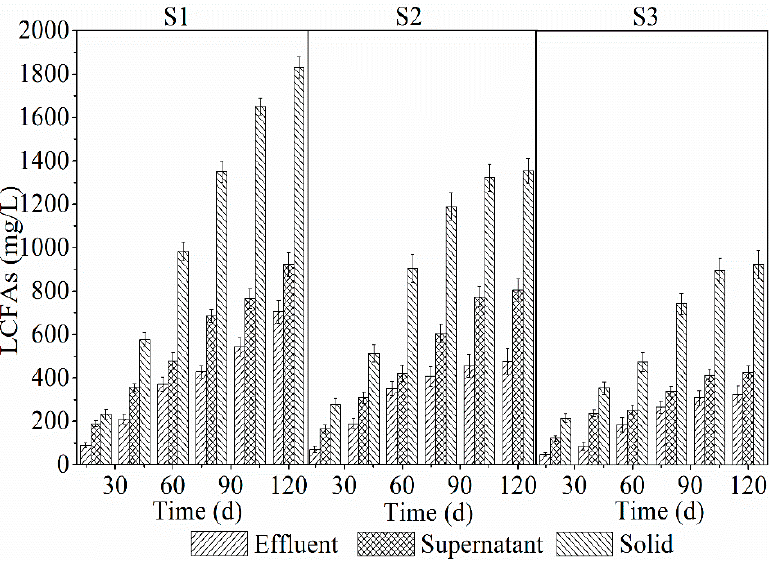
Figure 4. LCFAs accumulation and distribution of AnMBR reactor under different cycle frequencies.